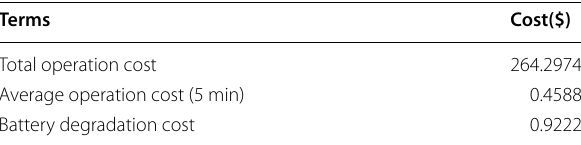
Table 2 Numerical